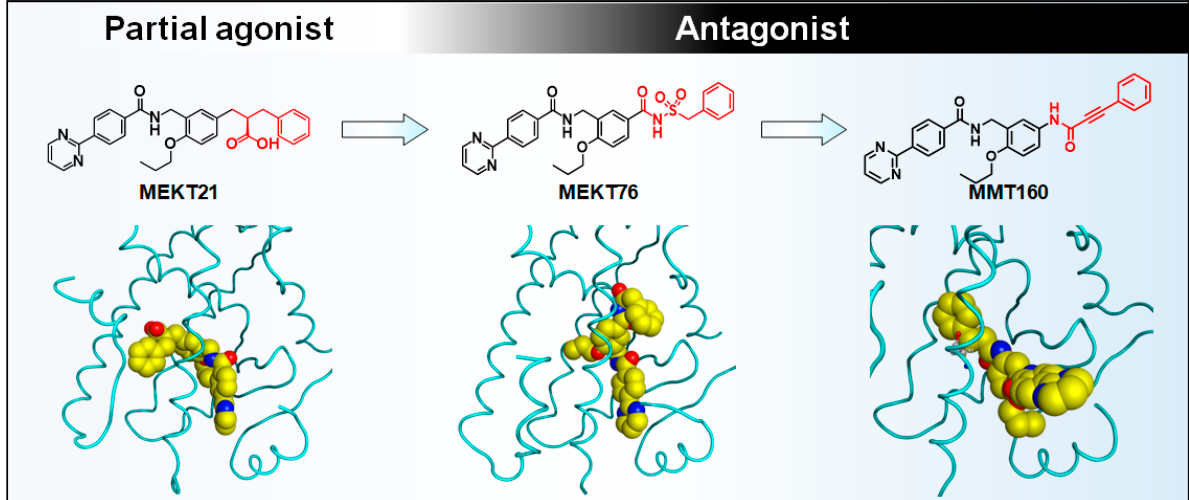
Figure 12. The structural development of an hPPAR γ antagonist from an hPPAR γ agonist. The structures and binding modes of MEKT ‐ 21, MEKT ‐ 75, and MMT ‐ 160 are depicted.